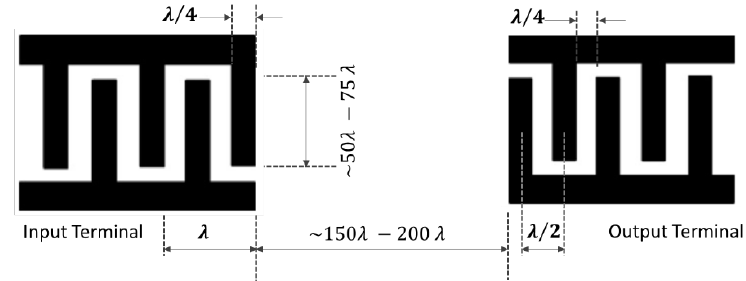
Figure 10. Schematic representation of the bi-directional electrodes